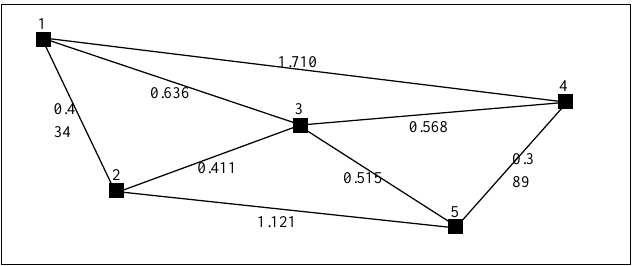
Figure 1: Network used to Find Shortest